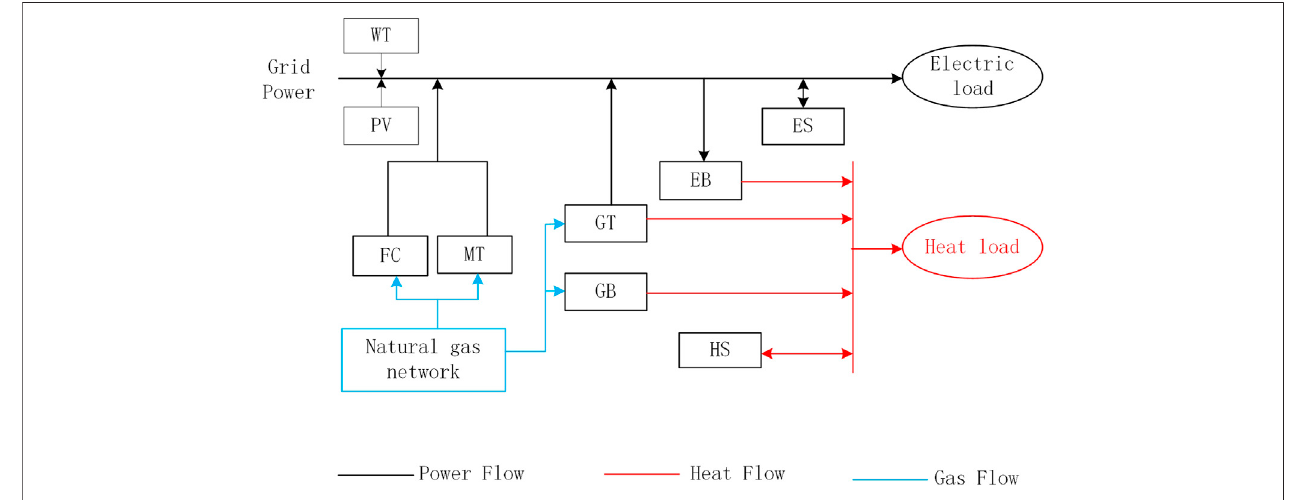
FIGURE 1 | IES structure and energy fl